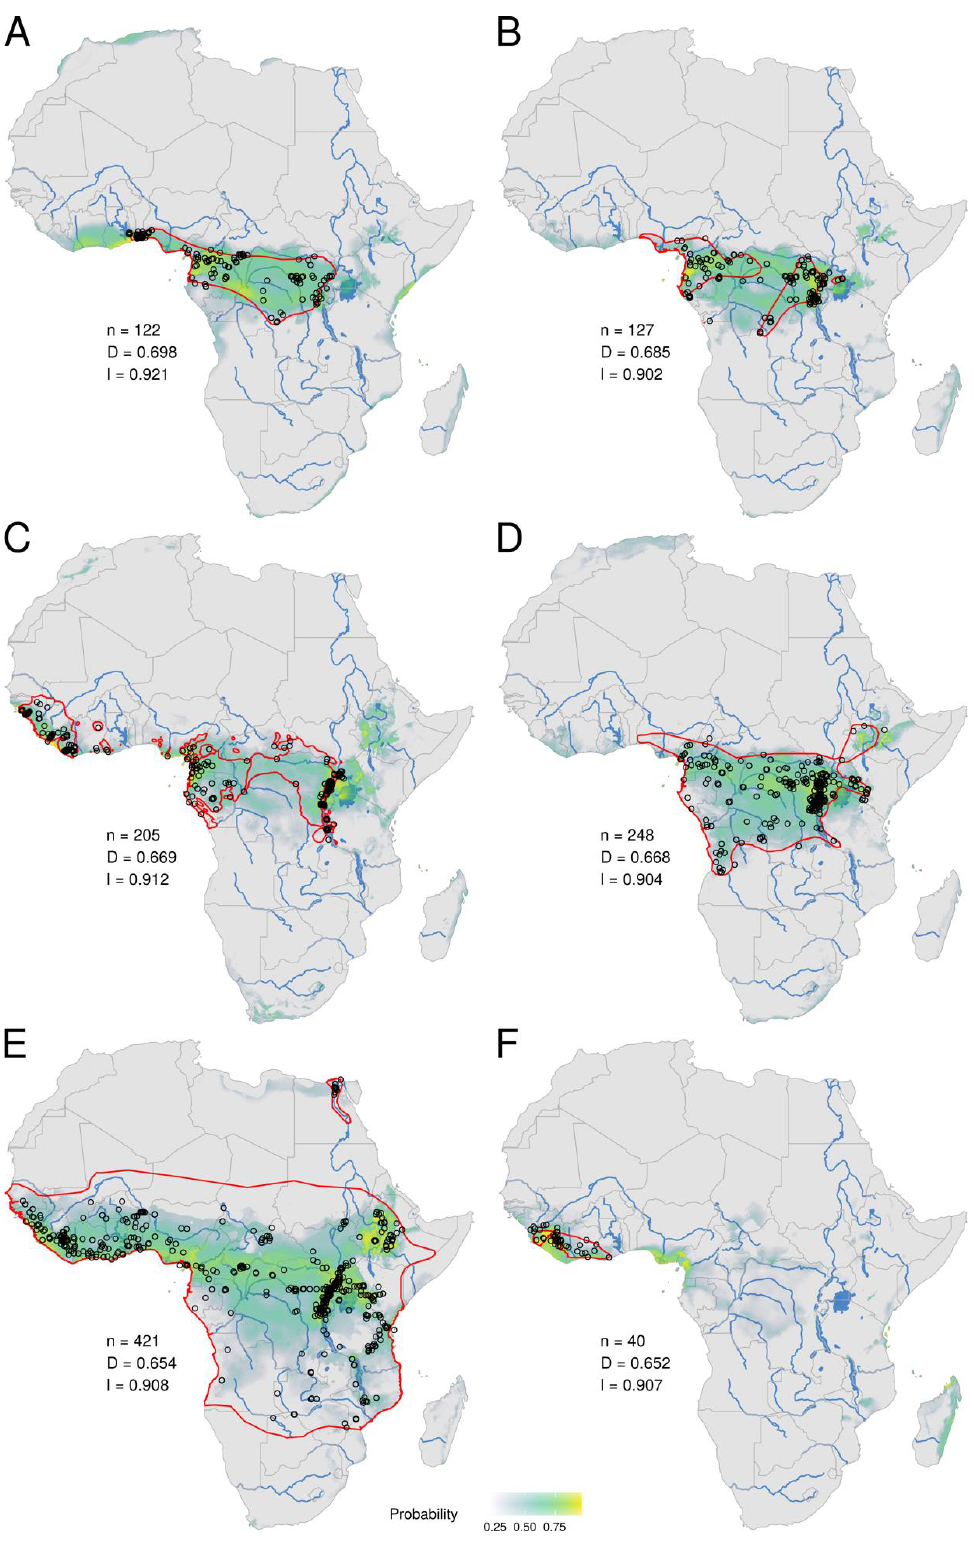
Figure 2. Ecological niches of mammal species ranked between the 5th and 10th positions for their overlap with the MPXV niche. Stochomys longicaudatus ( A ), Malacomys longipes ( B ), Pan troglodytes ( C ), Oenomys hypoxanthus ( D ), Crocidura olivieri ( E ), and Crocidura theresae ( F ). See legend of Figure 1 for more details.